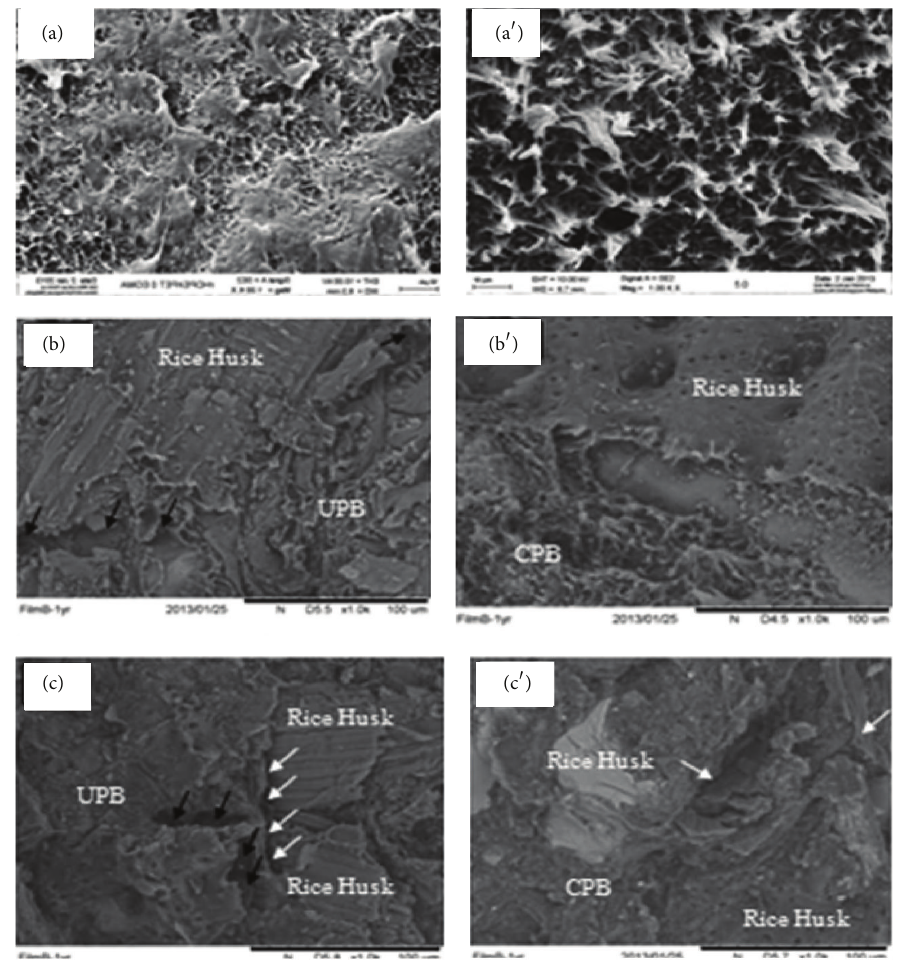
Figure 8: SEM micrographs of (a) 0 wt% UPB, (a 󸀠 ) 0wt% CPB, (b) 40 wt% RHF-UPB composite, (b 󸀠 ) 40 wt% RHF-CPB composite,